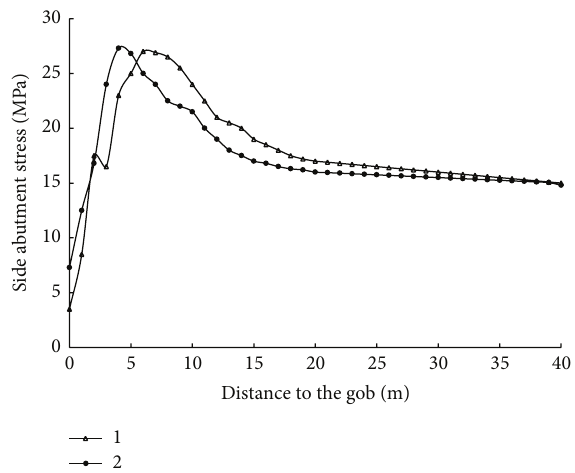
Figure 11: Distribution of the side abutment stress for the main roof with different breakage position. 1—main roof breaking in the deep area of the coal mass; 2—main roof breaking at the gob side.